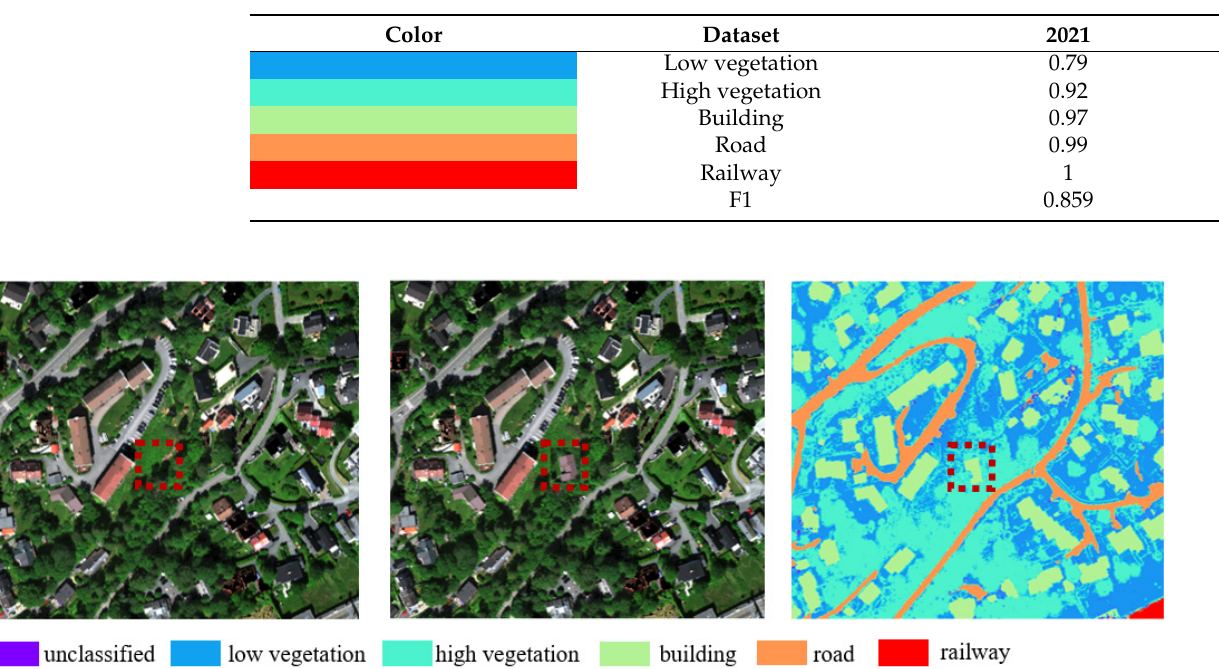
Figure 12. Simulated change in the dataset from 2021. The red dashed rectangle represents an added building in place of low/high vegetation.